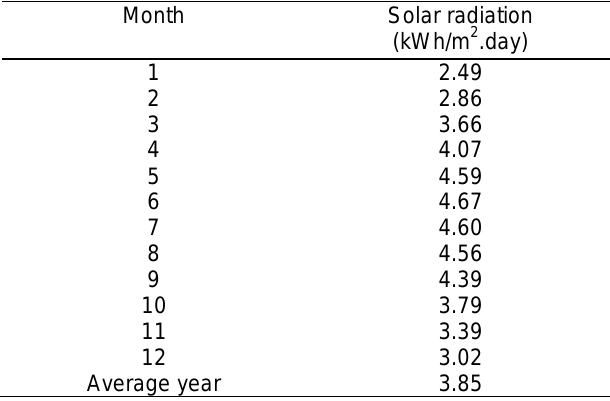
Table 1. Daily solar radiation value in Hanoi city Month Solar radiation (kWh/m 2